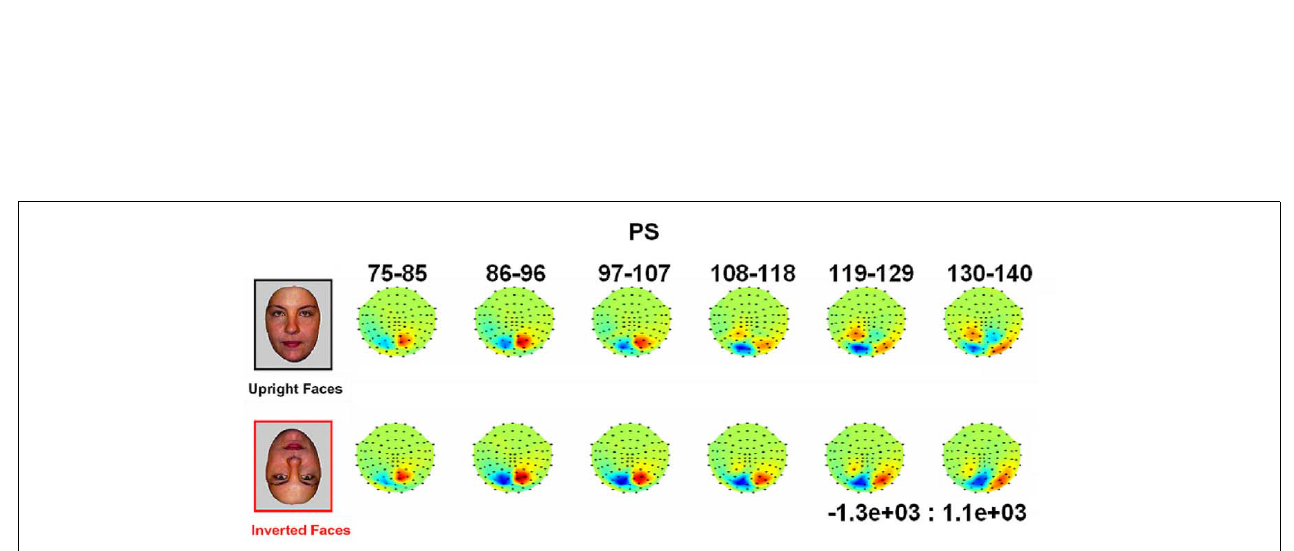
FIGUREA8 | Evolution of magnetic fields evoked by visual stimulation as recorded by 102 magnetometers for patient PS averaged across 10ms time windows around the M100 component in Experiment 2 (viewed from above, nasion upward; data are interpolated linearly